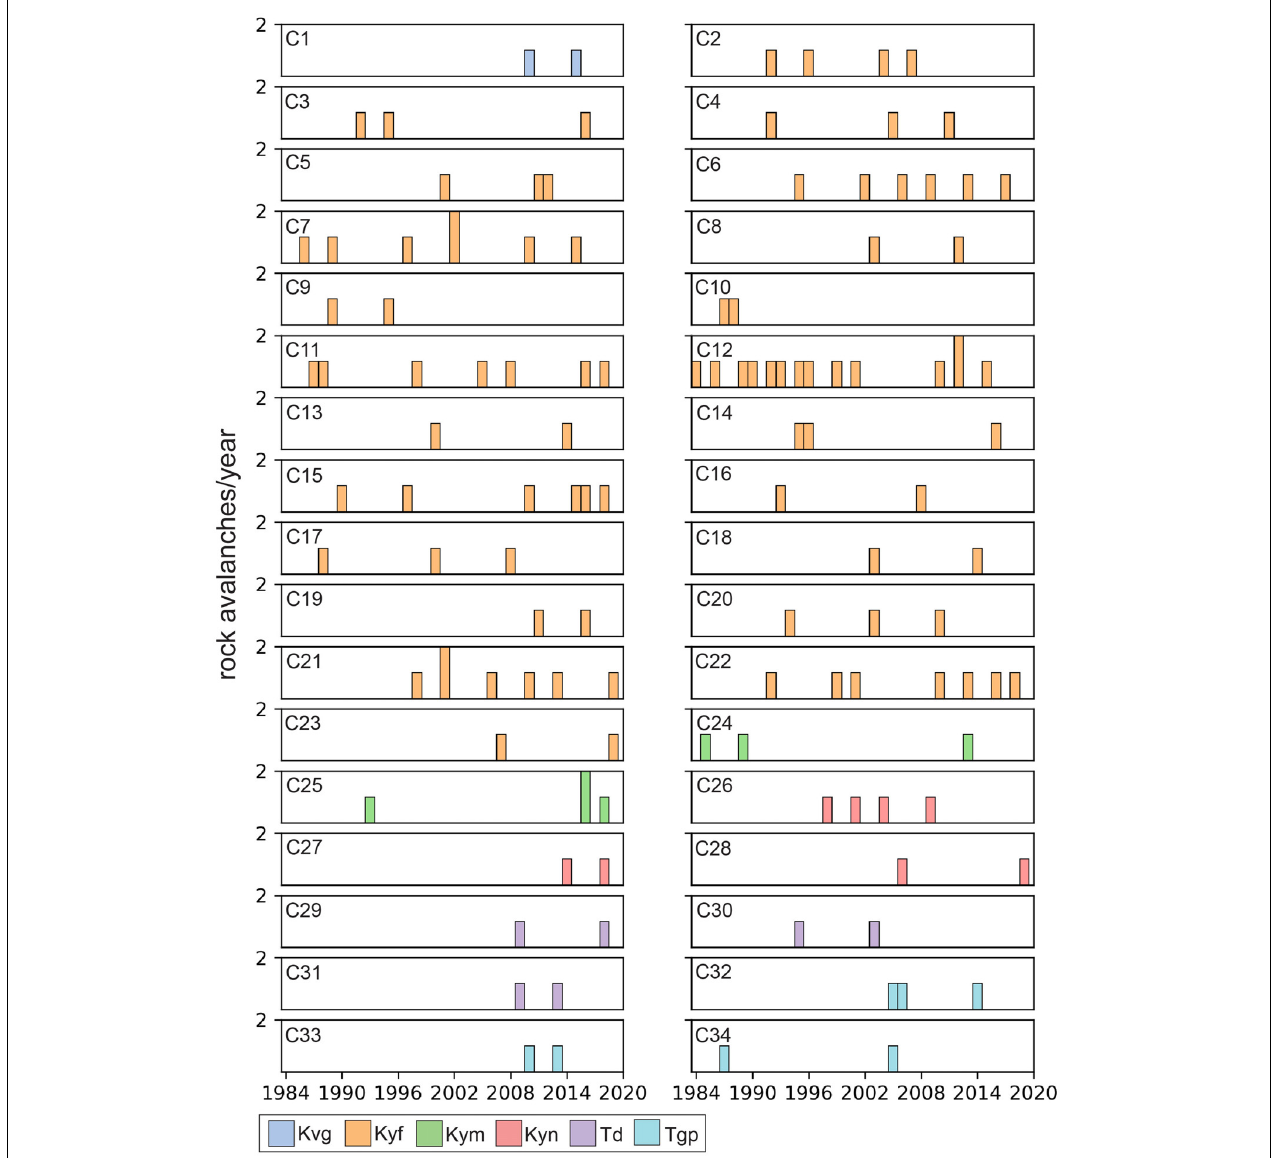
FIGURE 8 | Histograms showing the timing of clustered rock avalanche failures in the flysch (Kyf) and mélange (Kym) members of the Yakutat Group, schist of Nunatak Fiord (Kyn), gneiss and schist of the Chugach terrane (Kvg), granitic plutons (Tgp), and rhyolite porphyry and granite (Td) in the Saint Elias study area between 1984 and